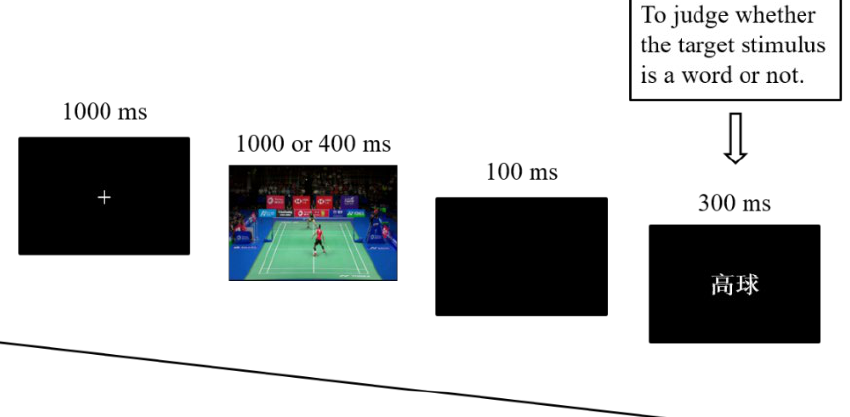
Figure 1. Experimental procedure in this